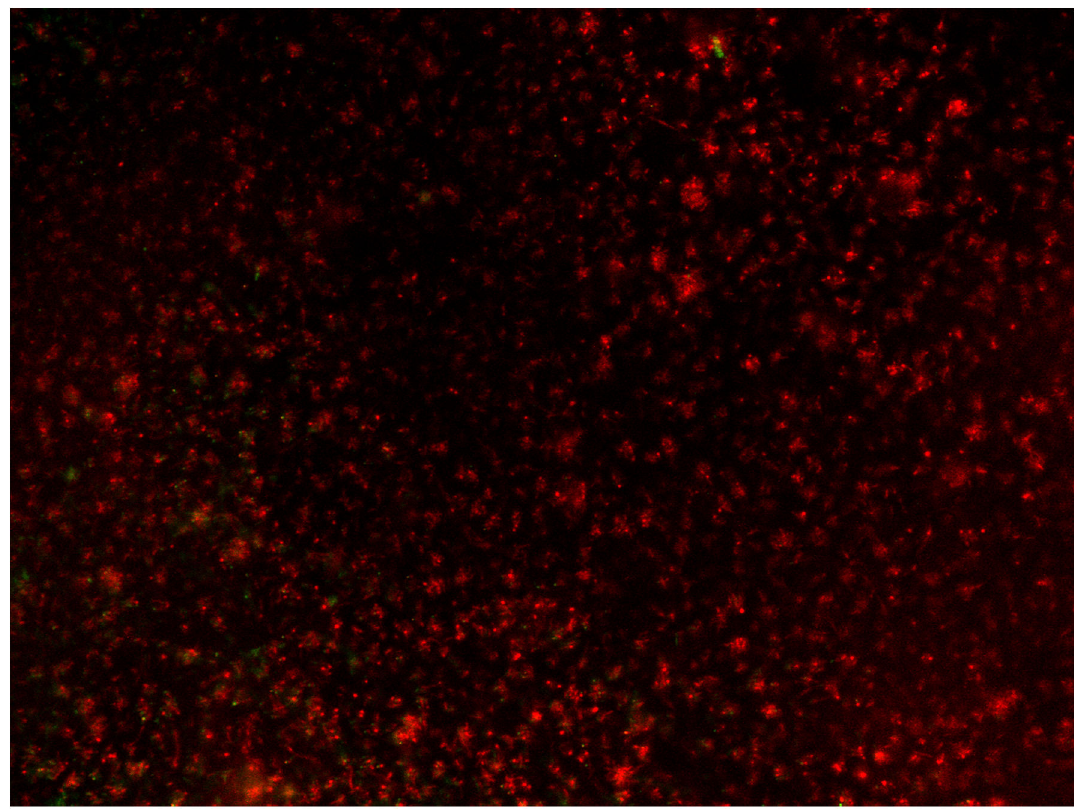
Figure 4. Superimposed fluorescence microscopic image (magnification 400 fold) of vital (green) and non-vital (red) colonization with A. viscosus on material A after